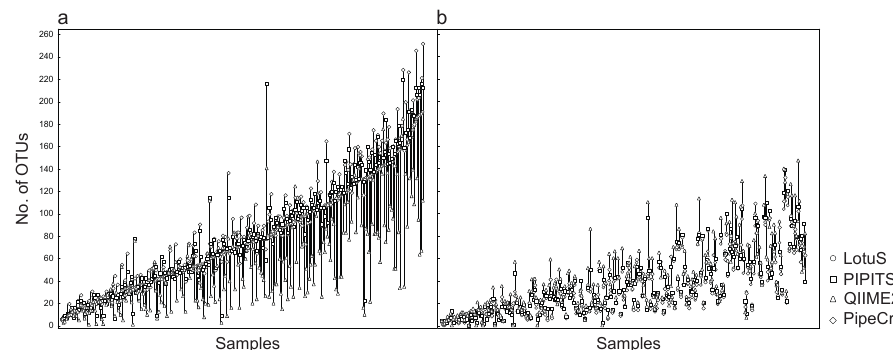
Figure 3. Number of OTUs per sample for Illumina data recorded from a) pipeline-generated OTU tables (median differences = 38 OTUs) and from b) filtered OTU tables (median differences = 12 OTUs). The Galaxy workflow was excluded